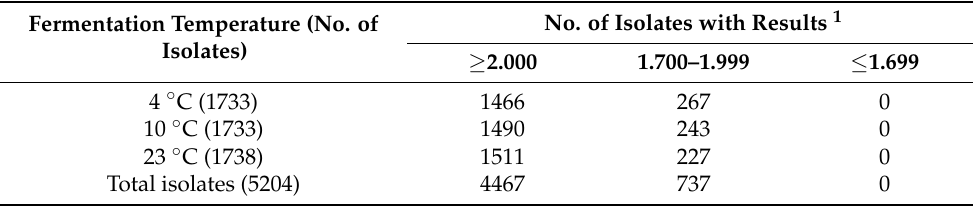
Table 1. Comparison of log score values obtained from fermented kimchi samples of microbials, based on MALDI-TOF in-house